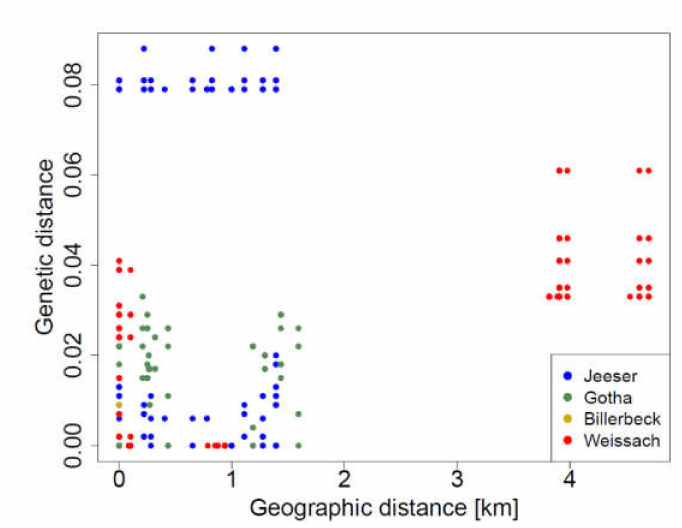
Figure 5. Relationships between TULV S segment sequences within the four study areas in Germany. Mantel tests detected significant isolation-by-distance patterns in the Weissach study area (red points; p < 0.0001) while there were no significant associations in the other sampling regions (all p >